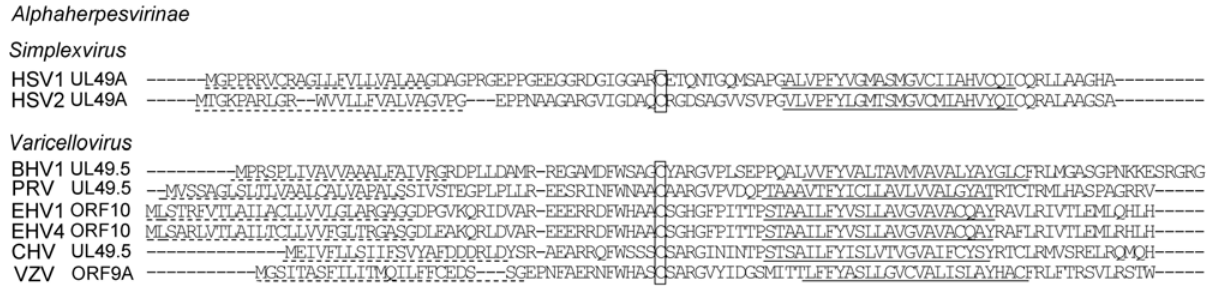
Figure 1. Alignment of the amino acid sequences of UL49.5 homologs of a selection of alphaherpesviruses (NCBI accession numbers are summarized in Materials and Methods). Hydrophobic residues indicative of N-terminal signal sequences (dashed line) and membrane anchor regions (bold line) are indicated. The conserved cysteine residue involved in disulfide bond formation with the viral glycoprotein M is indicated. The amino acid sequence alignment of UL49.5 homologs was performed using Vector NTI software